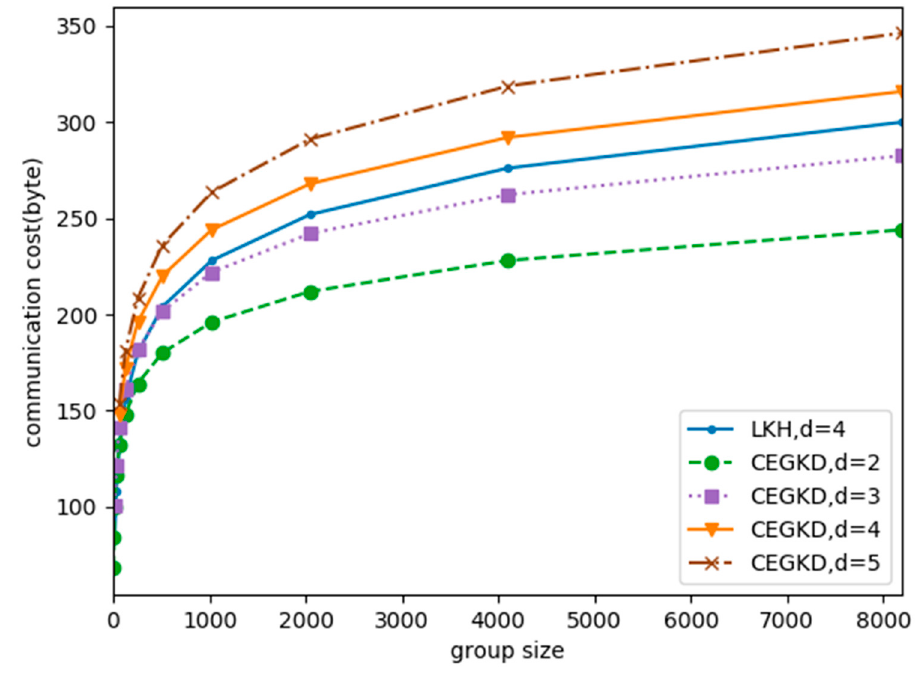
Figure 4. CEGKD and LKH communication cost.